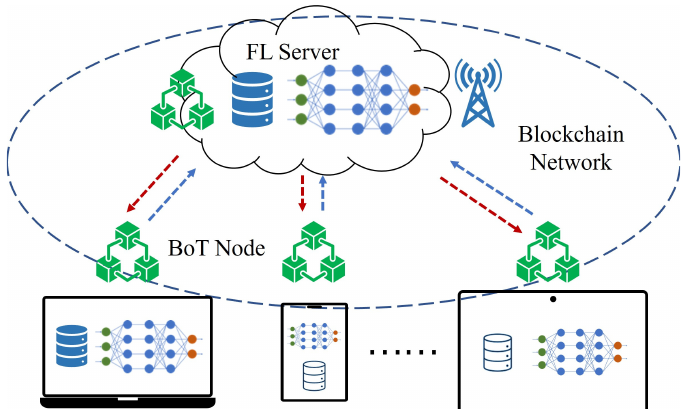
Figure 2. The proposed IoT resource management framework incorporating blockchain and federated learning technologies.